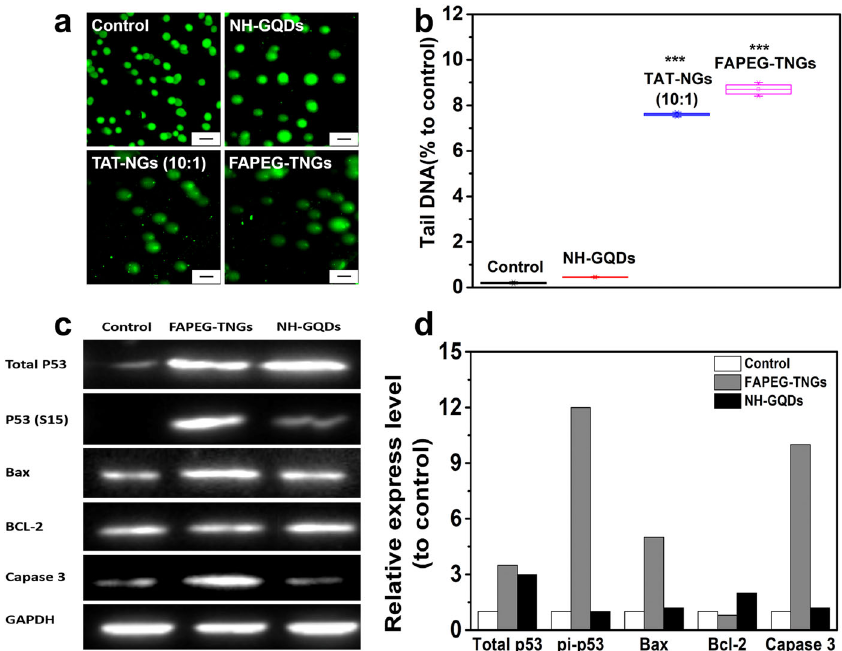
Fig. 8 Induction of DNA damage in HeLa cells by NH-GQDs derivatives. a Example images of comet tails for HeLa cells treated with NH-GQDs, TAT-NGs (10:1), or FAPEG-TNGs for 24 h. Scale bars, 20 μ m. b Statistics of the percentages of DNA in the tails of the cells, calculated using CASP software. c Western blot analysis of total p53, pi-p53, Bax, Bcl-2, Caspase 3, and GAPDH (reference protein) in HeLa cells after 24 h of treatment with FAPEG-TNGs or NH-GQDs. d Relative quantities of total p53, pi-p53, Bax, Bcl-2 and Caspase